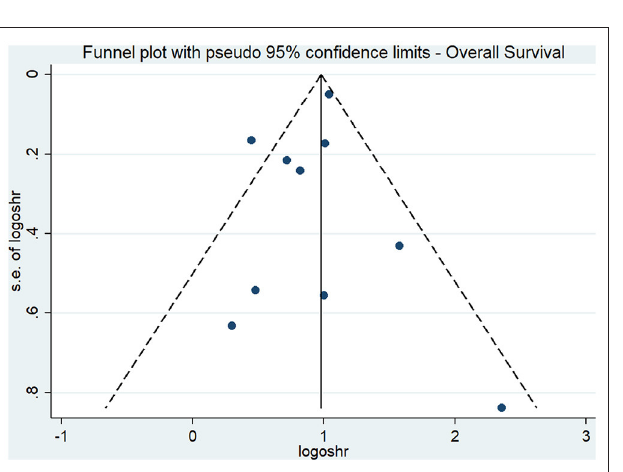
FIGURE 3 | Funnel plot for overall